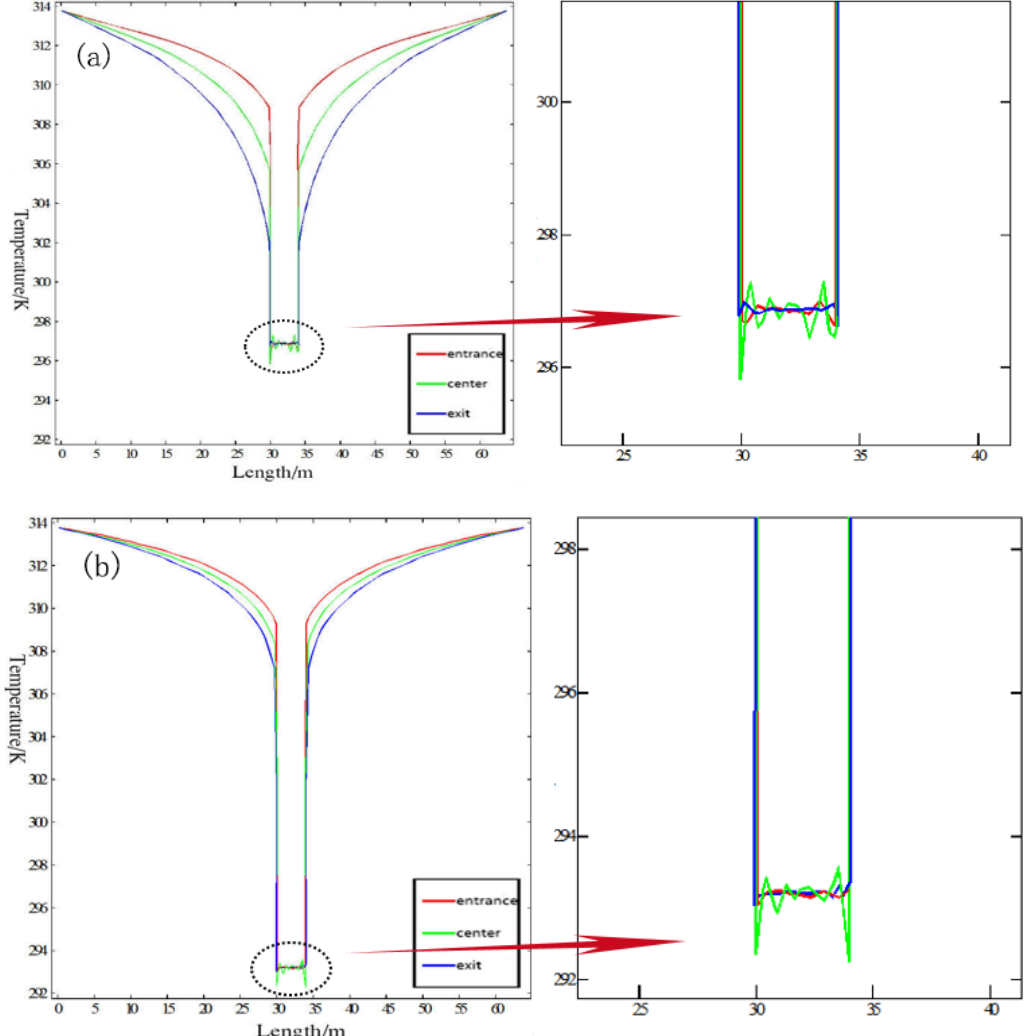
Figure 12. Temperature statistics of materials along standard straight lines: ( a ) temperature chart of concrete material; ( b ) temperature chart of test specimen XX45.